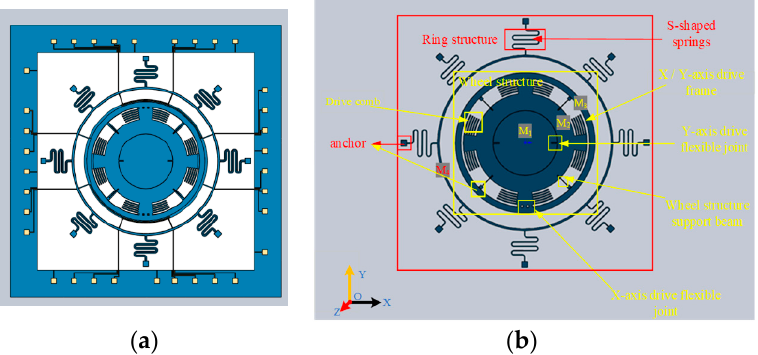
Figure 1. Schematic of the wheel-ring gyroscope: ( a ) Complete structure; ( b ) structure description